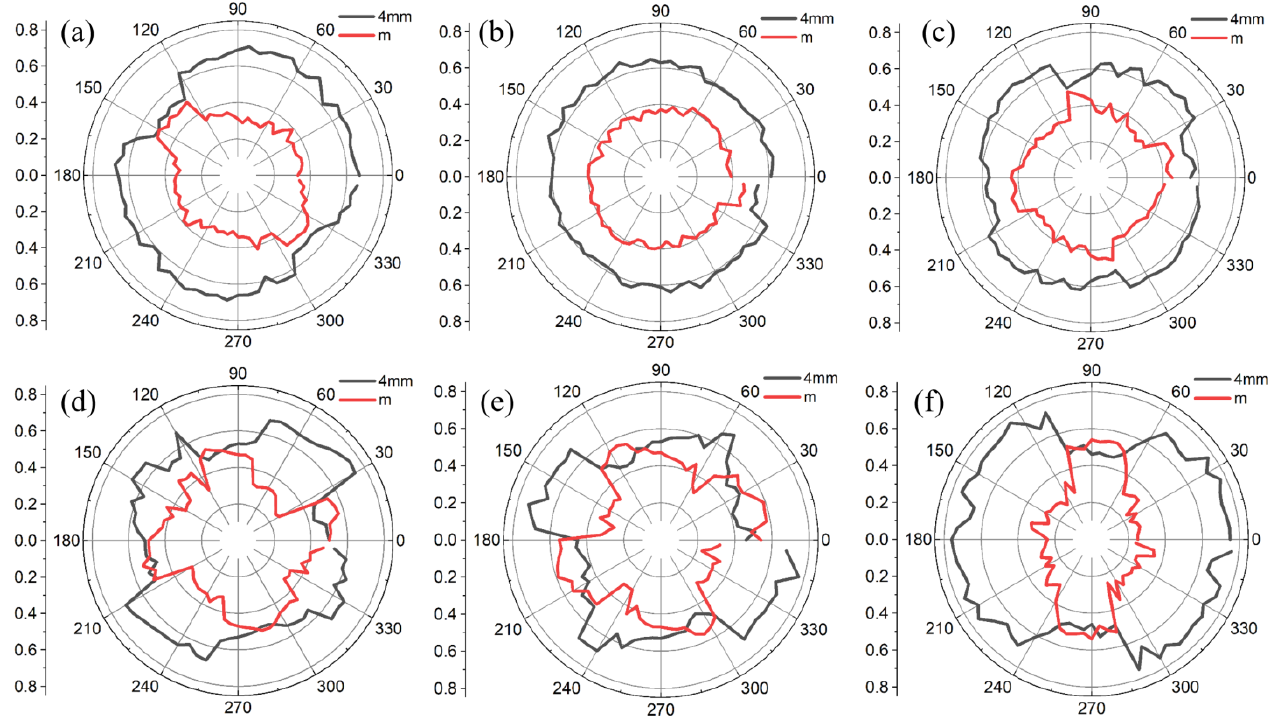
Figure 5. Ratio of monoclinic and tetragonal phases in six different spherulites on silicon (shown in Figure 3). 1 – 6 on Figure 3 correspond to ( a – f ) here respectively. The polar angle on the graphs is the polar angle of the study area on the spherulite. Silicon substrate.